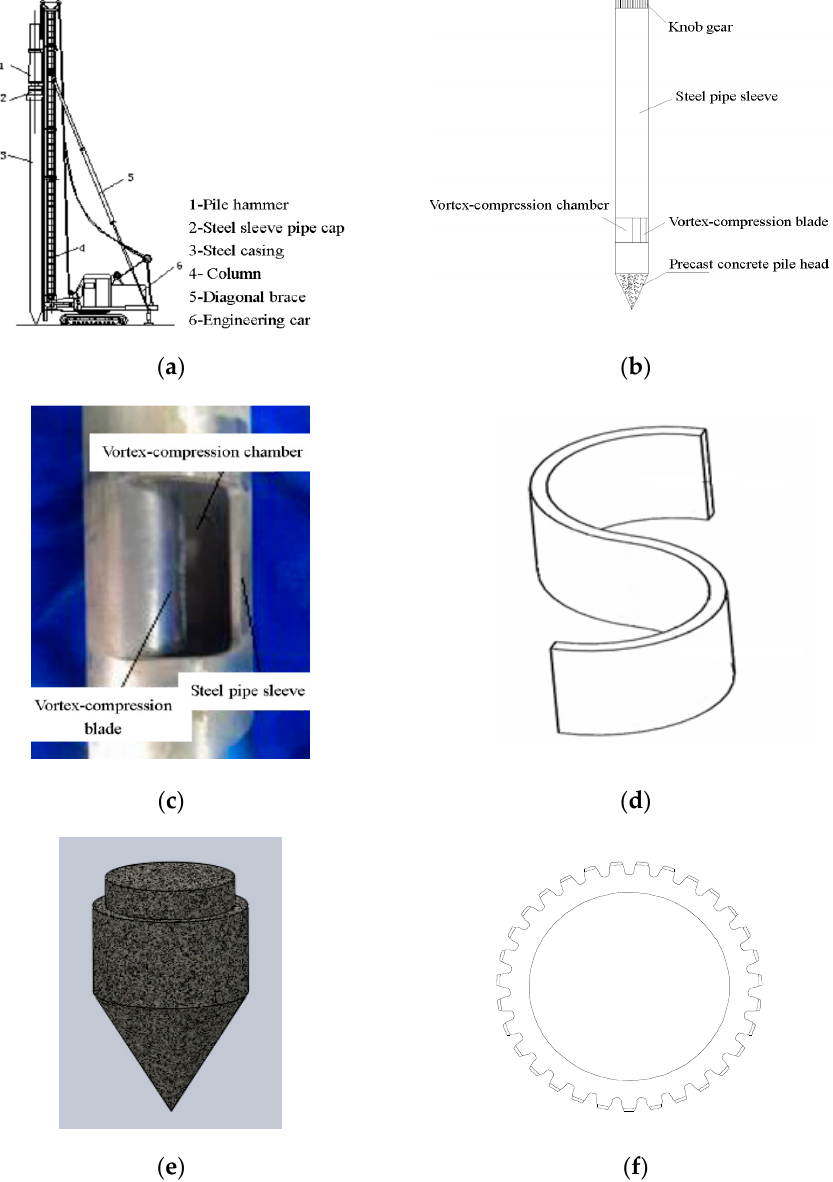
Figure 3. Pile forming equipment of the nodular pile: ( a ) schematic diagram of pile frame; ( b ) schematic diagram of vortex-compression steel pipe; ( c ) physical drawing of vortex-compression chamber; ( d ) 3D diagram of vortex-compression blade; ( e ) 3D drawing of precast concrete pile head; ( f ) plan of knob gear.